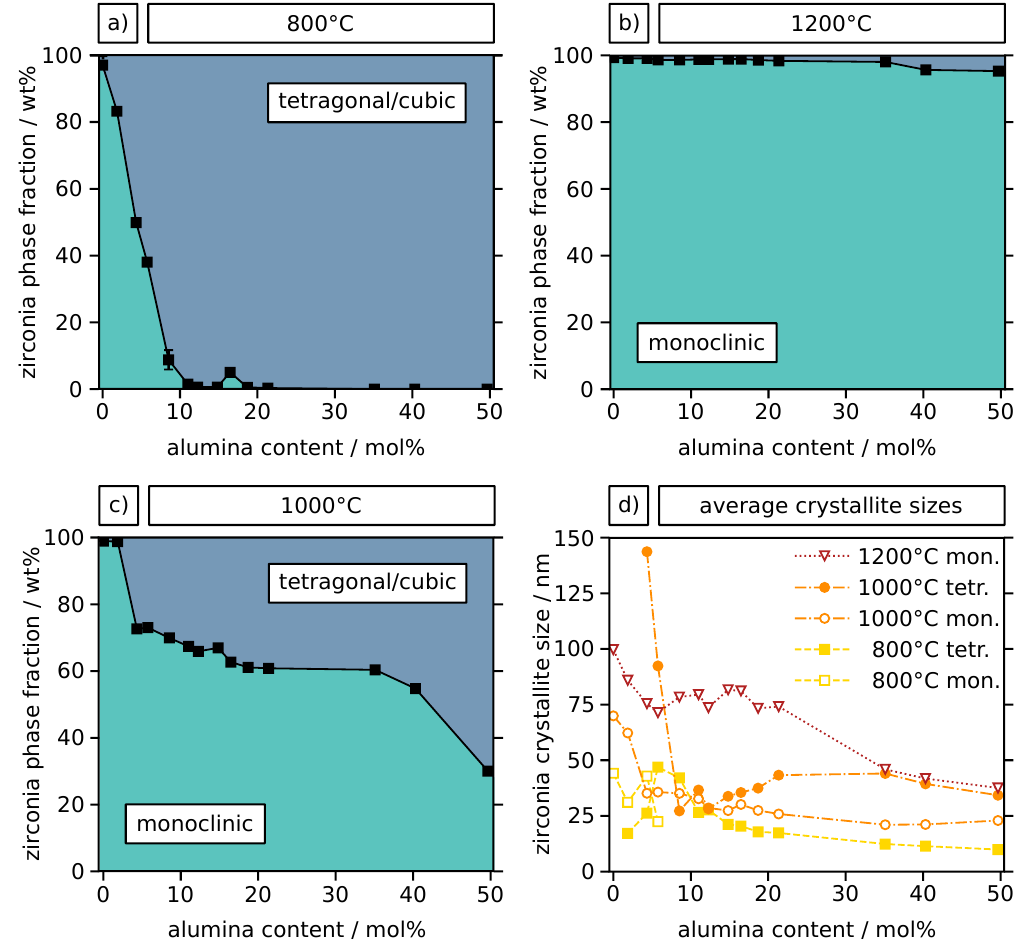
Figure 5. Quantitative phase analysis and crystallite sizes of Al-doped zirconia particles with different Al content after annealing at ( a ) 800 ◦ C, ( b ) 1000 ◦ C and ( c ) 1200 ◦ C for 3h, from XRD data using Rietveld refinement. The phase compositions are shown as weight fractions of the zirconia tetragonal/cubic and monoclinic phases. ( d ) Monoclinic and tetragonal crystallite sizes were obtained from the same data and are only shown for crystal phases with a minimum weight fraction of